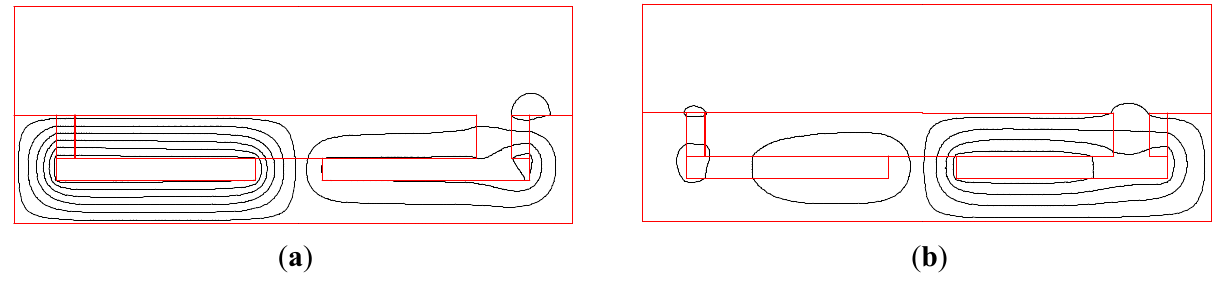
Figure 3. Magnetic flux lines distribution. ( a ) Steady state; ( b ) Action.